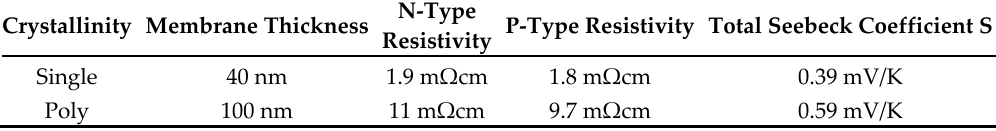
Table 2. Comparison of properties of SC [1] and polycrystalline silicon nanomembranes.